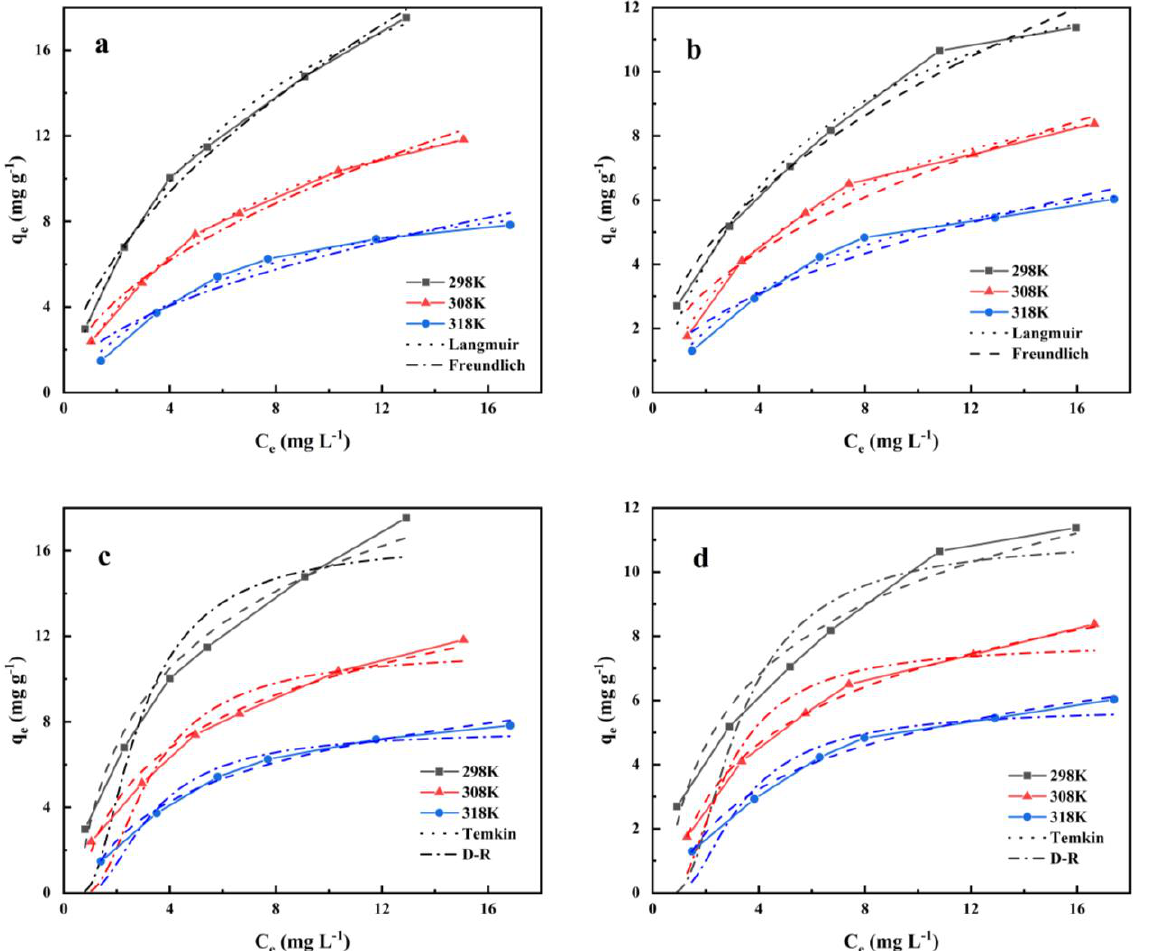
Figure 8. Adsorption isotherms for F − and parameters fitted by Langmuir, Freundlich, D-R, Temkin models of ( a , c ) PTB-LDO3 and ( b , d ) PTB-LDO4 (solutions: 2, 5, 8, 10, 15, 20mg L − 1 , pH = 5.5, 0.40 g L −1 dosages, 3 h).